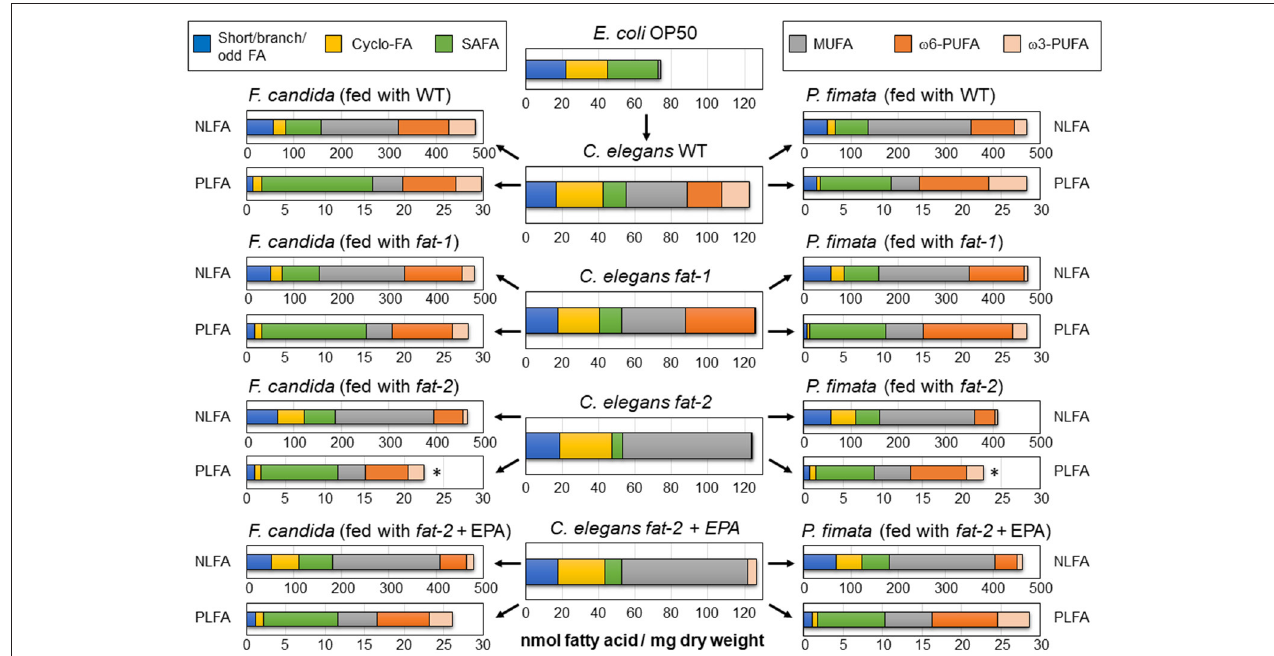
FIGURE 1 | Amount of fatty acids neutral lipid (NLFA) and phospholipid (PLFA) fatty acid fractions (in nmol fatty acid mg dry weight − 1 ) of Collembola consumers (left - Folsomia candida , right - Protaphorura fimata ) and total lipids of food sources ( Escherichia coli OP50 and the different Caenorhabditis elegans strains). Short/branch/odd FA – (12:0, 13:0, 13:0 iso), 14:0, (14:0 iso, 14:1 ω 7, 14:1 ω 9, 15:0, 15:0 iso), 16:0 iso, 17:0, 17:0 iso and 17:1 ω 8; Cyclo-FA – 17:0 cyclo, 19:0 cyclo; SAFA – 16:0, 18:0, 20:0; MUFA – (16:1 ω 5), 16:1 ω 7, (18:1 ω 5), 18:1 ω 7, 18:1 ω 9, (20:1 ω 6) and 20:1 ω 9; ω 6-PUFA – 18:2 ω 6, 18:3 ω 6, 20:2 ω 6, 20:3 ω 6 and 20:4 ω 6; ω 3-PUFA – 20:5 ω 3. Fatty acids in parenthesis were only detected in NLFA samples and fatty acids of carbon chain-lengths < 14 were not detected in Collembola samples. One-way ANOVA followed by Bonferroni post-hoc test with * as P < 0.05 when compared to the corresponding wild type fed control.